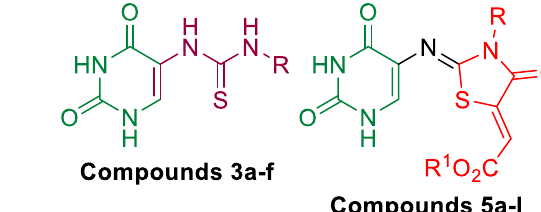
TABLE 4 Antiproliferative activity of compounds 3a-f, 5a-l, and Doxorubicin.